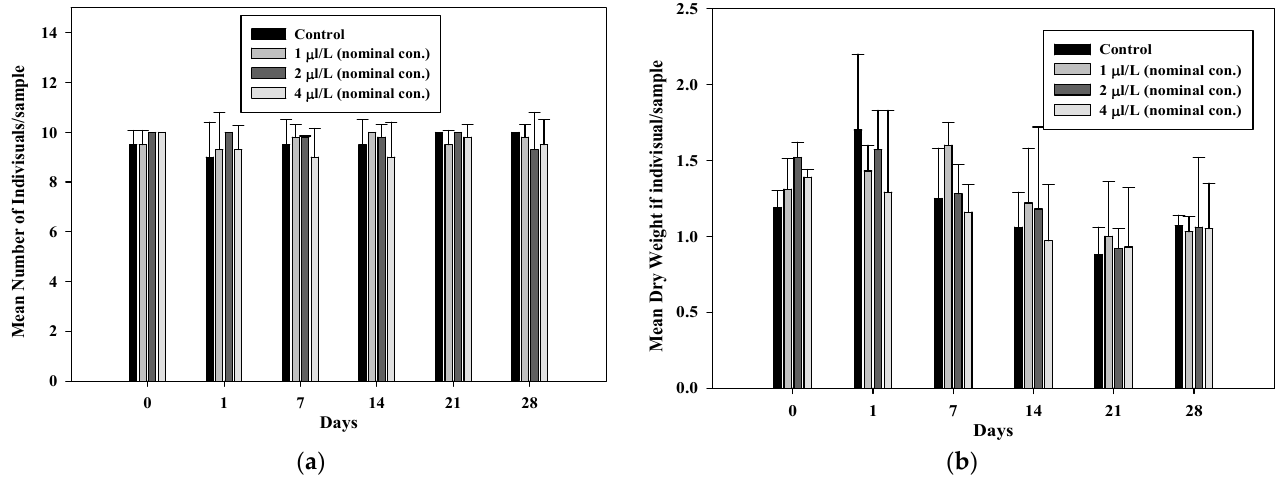
Figure 4. Mean number of G. tokunagai individuals/sample after benzyl chloride exposure.